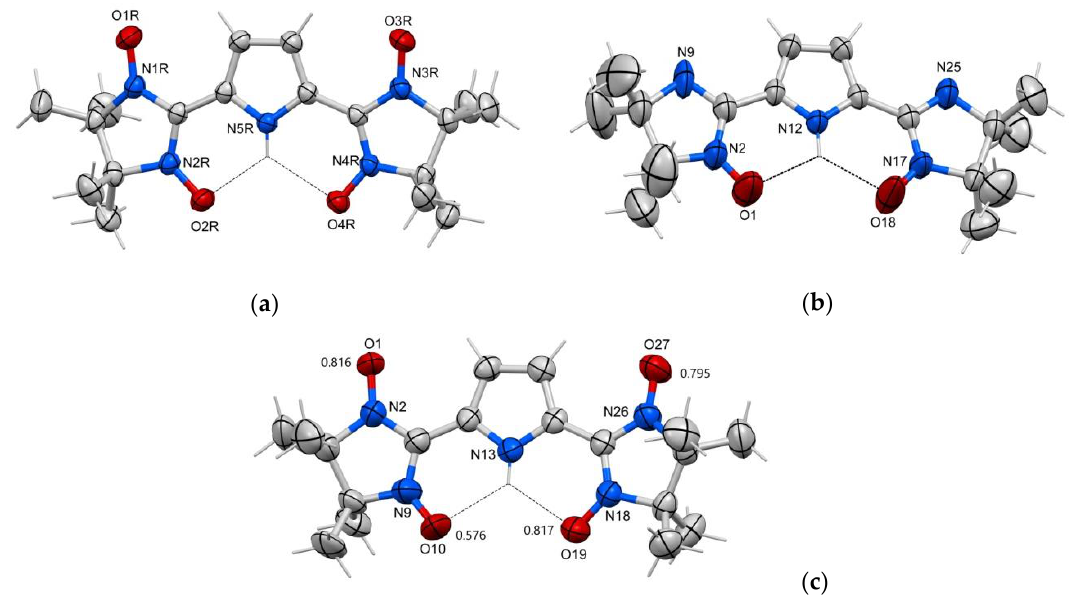
Figure 2. The structures of 1 ( a ), 2 ( b ), and 9 ( c ; occupancy of positions of O atoms is indicated). The thermal ellipsoids are set at a 50% probability level.